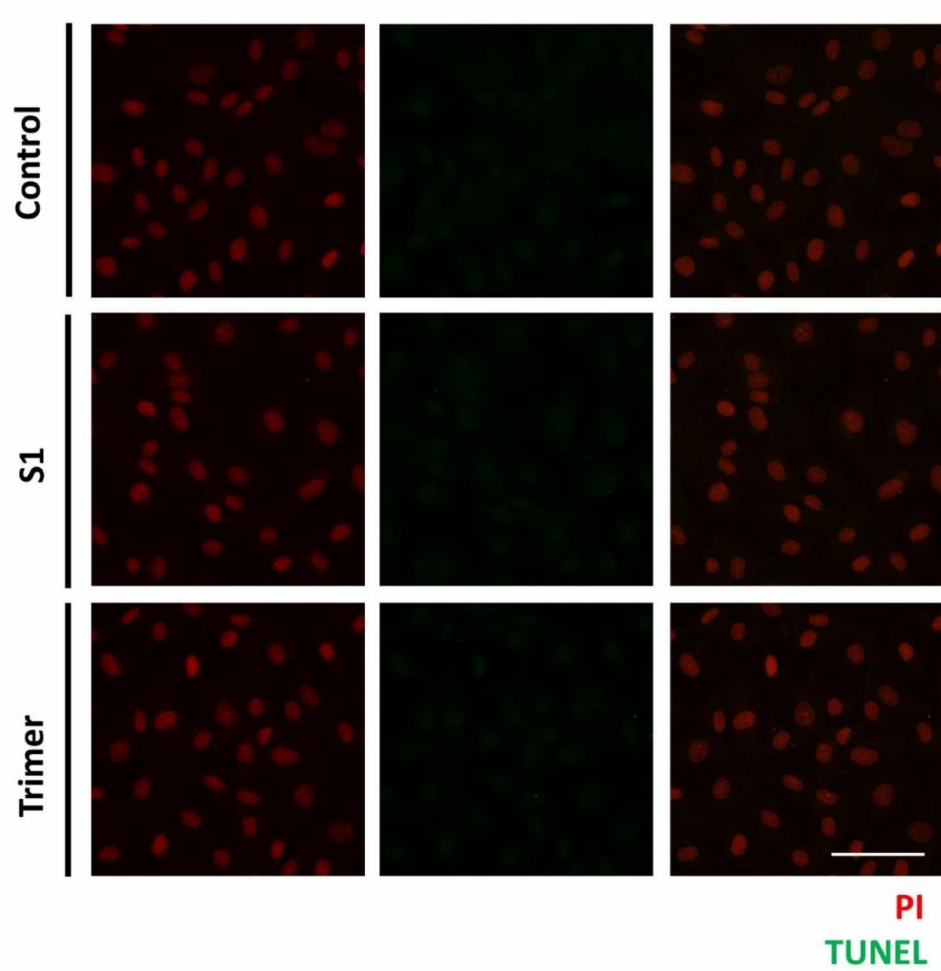
Figure 7. The spike proteins do not induce apoptosis in the human brain ECs. Human brain ECs were treated with 15 nM of S1 and active trimer for 24 h, respectively. DNA fragmentation, as the indicator for apoptotic changes, was assessed with Terminal deoxynucleotidyl transferase dUTP nick end labeling (TUNEL) assay. DNA fragmentation was labeled with AF488 conjugated anti-BrdU antibody (green), which was detected neither control nor the spike proteins (S1 and Trimer) treatment groups. Nucleus was counterstained with propidium iodide (PI, red). Scale bar, 75 µ